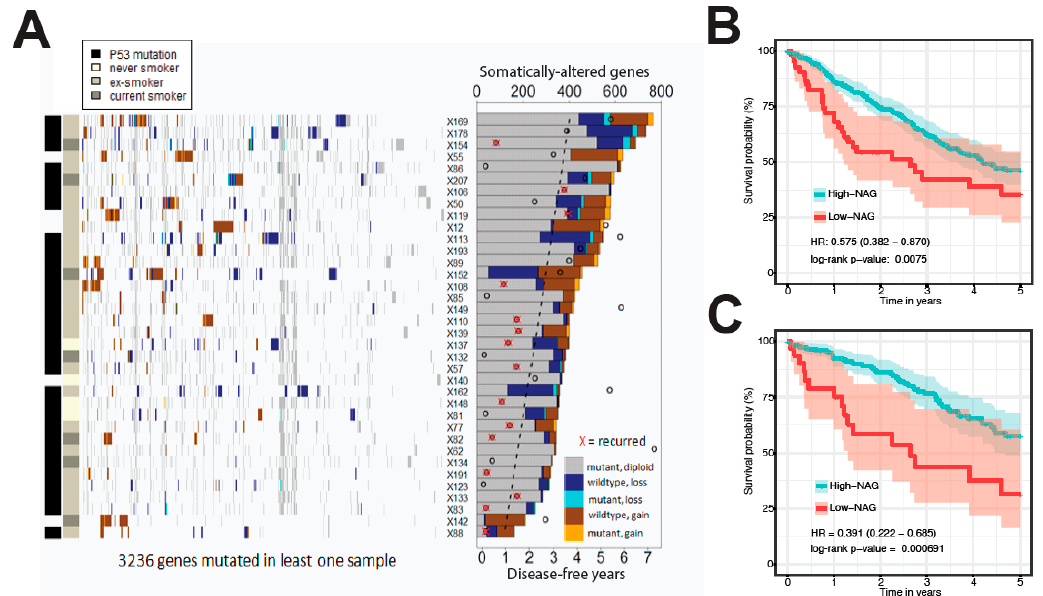
Figure 2. Association between somatic alterations found in PDXs and OS of patients. ( A ) A heatmap of SNVs and CNAs across PDX models in genes that have been altered at least once. The bar graph describes the total number of altered genes in each PDX (labeled by their ID preceded by “X”). Different combinations of SNV point mutations and CNAs are described by the side bar graph. Circles on the bar graph show the disease-free years to last follow-up, and the red “X” denotes the recurrence of disease for each PDX’s matched patient, while the dashed line shows the best fit running through them. Genes were ordered by hierarchical clustering across the samples. Kaplan–Meier curves show significant differences, as evidenced by the hazard ratio (HR), its confidence interval and log-rank test p -value, in the overall survival (OS) between high and low NAG in ( B ) all TCGA NSCLC patients and ( C ) only in stage I patients.